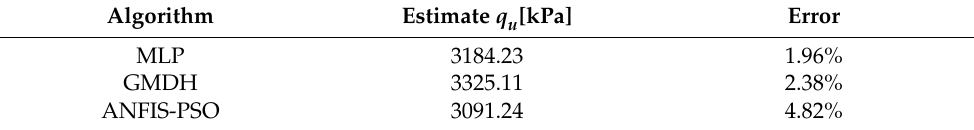
Table 6. Case study: seismic bearing capacity of the strip footing estimated by the investigated ML tools, and error with respect to the ground-truth to the value given by the Optum G2 software.